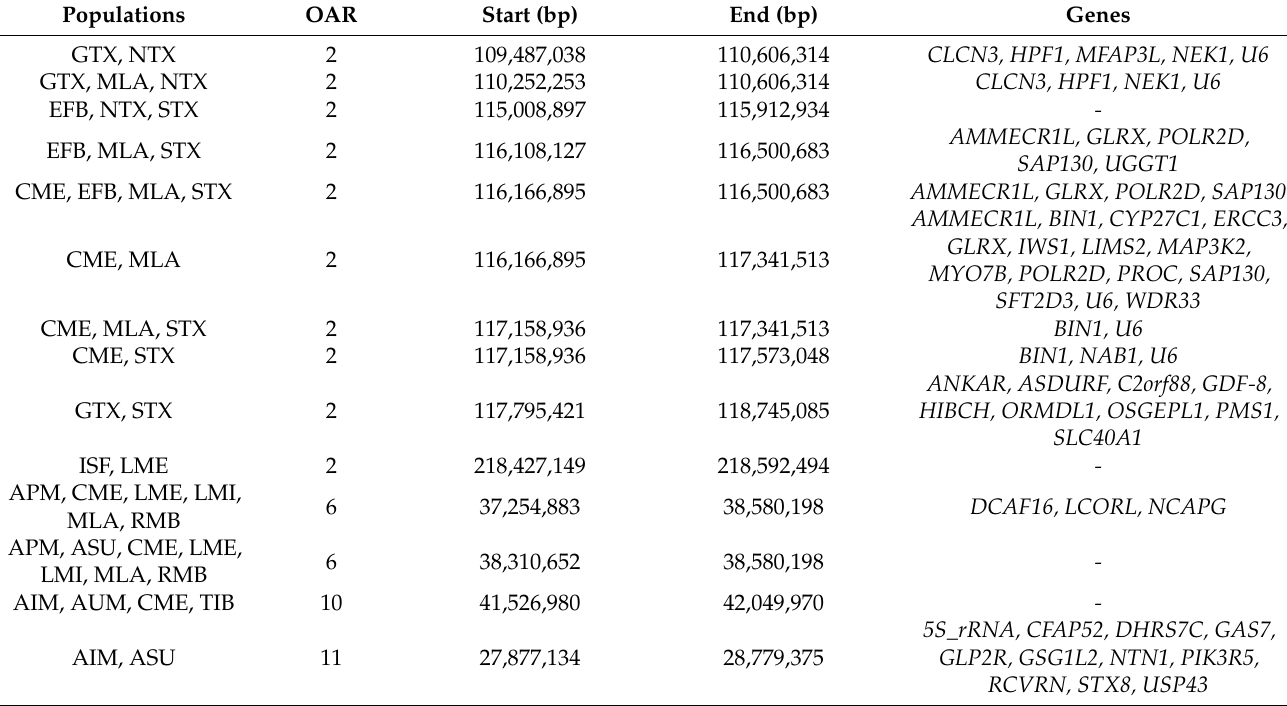
Table 5. Common genomic regions in ROH islands for two or more worldwide sheep populations and genes identified within.